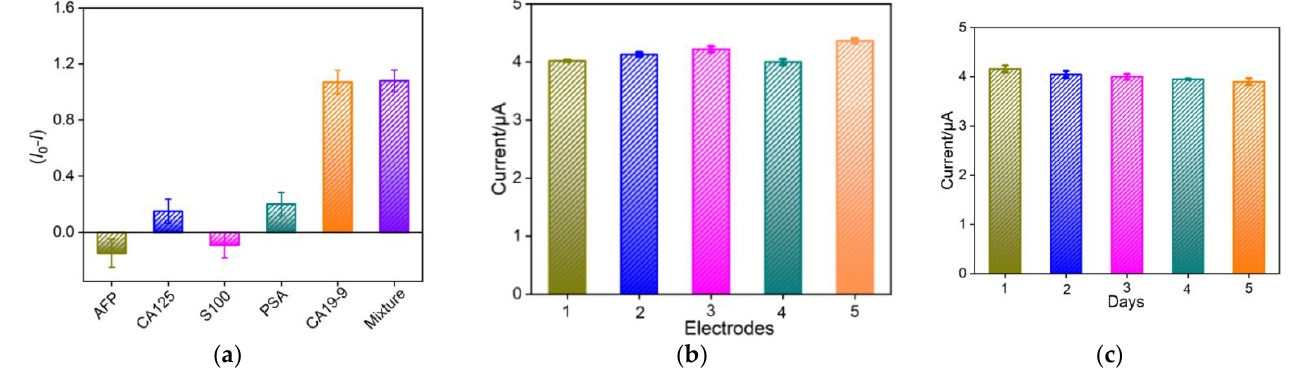
Figure 9. ( a ) Selectivity of the electrochemical immunosensors to CA19-9. (1) 1 ng/mL AFP; (2) 1